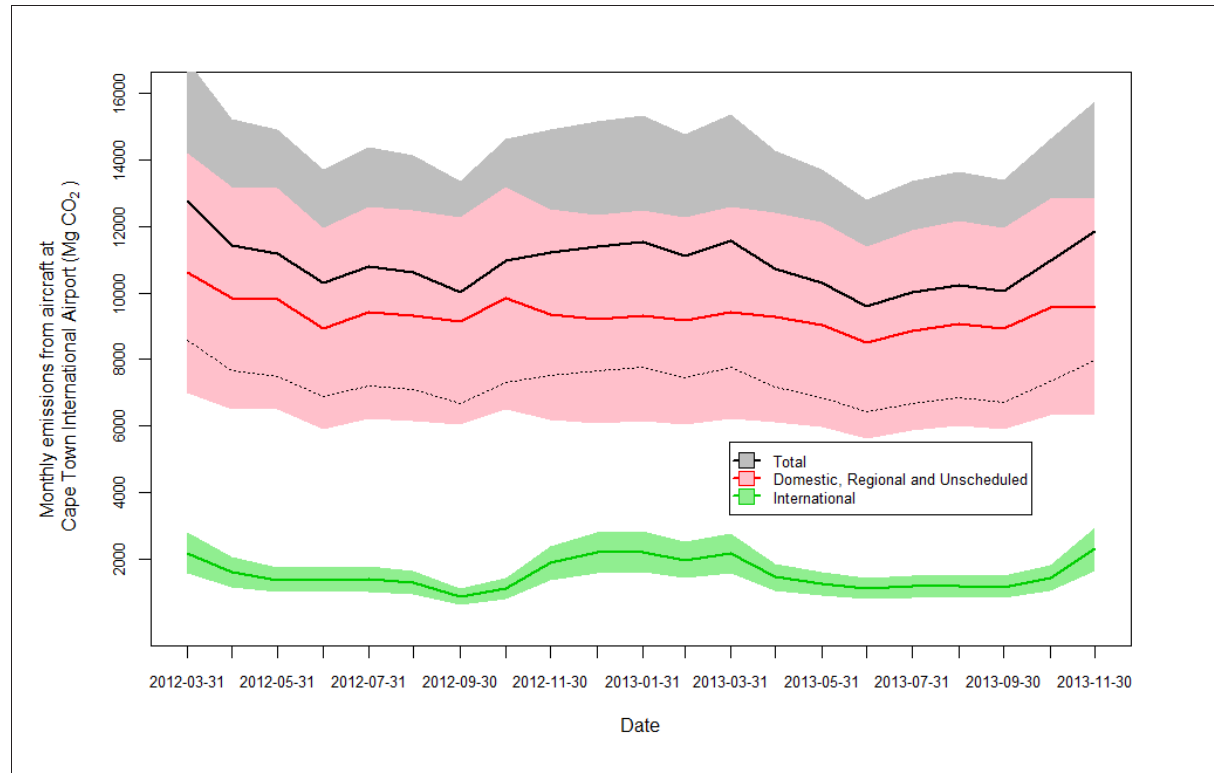
Figure 7: Monthly emissions from aircraft at Cape Town International Airport. The shaded region represents the level of uncertainty and the dashed line represents the lower limit of the total emissions from aircraft at the airport.